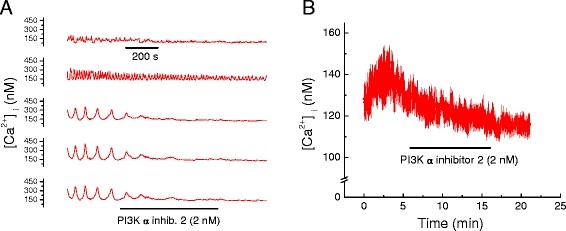
Pharmacologic inhibition of phosphoinositide-3-kinase (PI3K) isoform α inhibitor decreased Ca
2+
, [Ca
2+
]
i
, in HL-1 cell mouse cardiomyocytes.
A.
 Effect of PI3K α inhibitor 2 (2 nM) on [Ca2+]i oscillations in five representative HL-1 cells. Time base applies to all traces.
B.
 Effect of PI3K α inhibitor 2 (2 nM) on average [Ca2+]i in cells displaying oscillating and non-oscillating [Ca2+]i (mean ± SEM; n = 5, each an average of 25 to 40 cells as shown in A).